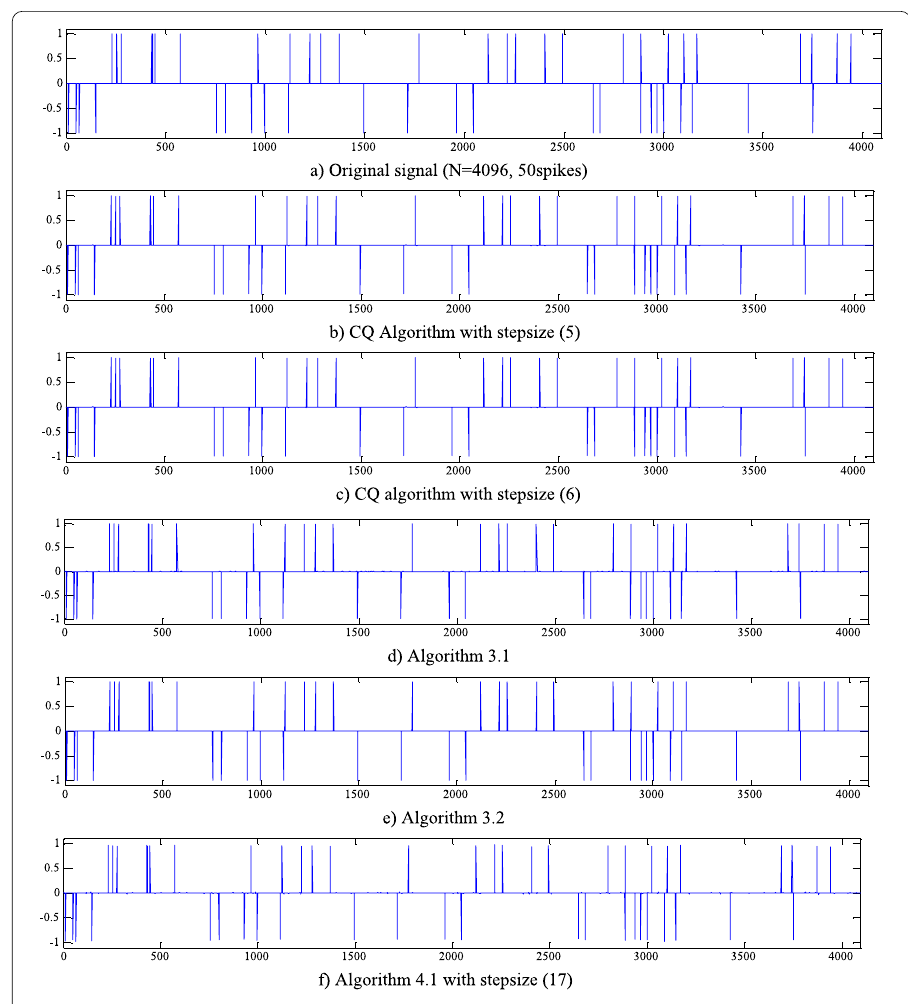
Figure 1 Compressed sensing problem, from top to bottom: original signal, results of CQ algorithm with stepsizes (1.5), (1.6), (3.3) and (3.14), the last is KM-CQ algorithm with stepsize (3.3).